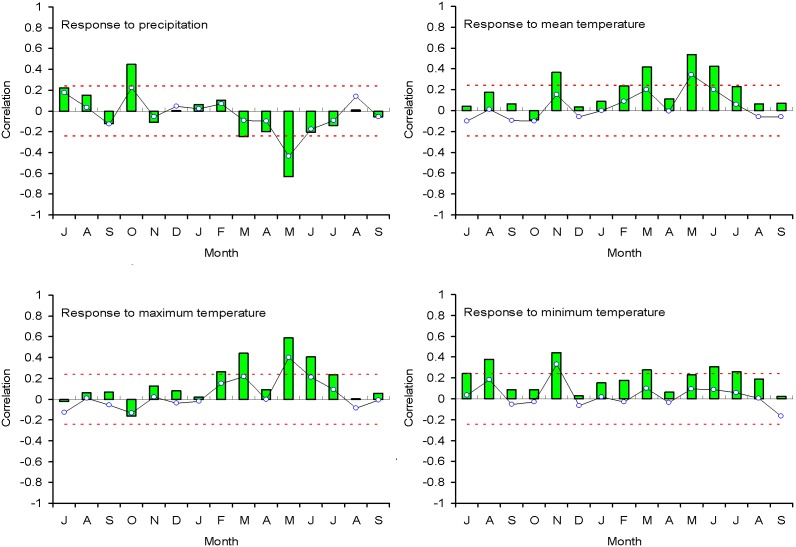
Simple correlations (bars) and response functions (lines) of the standard chronology of the Shimen Mountains with the monthly sum of precipitation and the monthly mean temperature from previous July to current September (1953–2008).The dotted lines indicate significant variables (p<0.05).